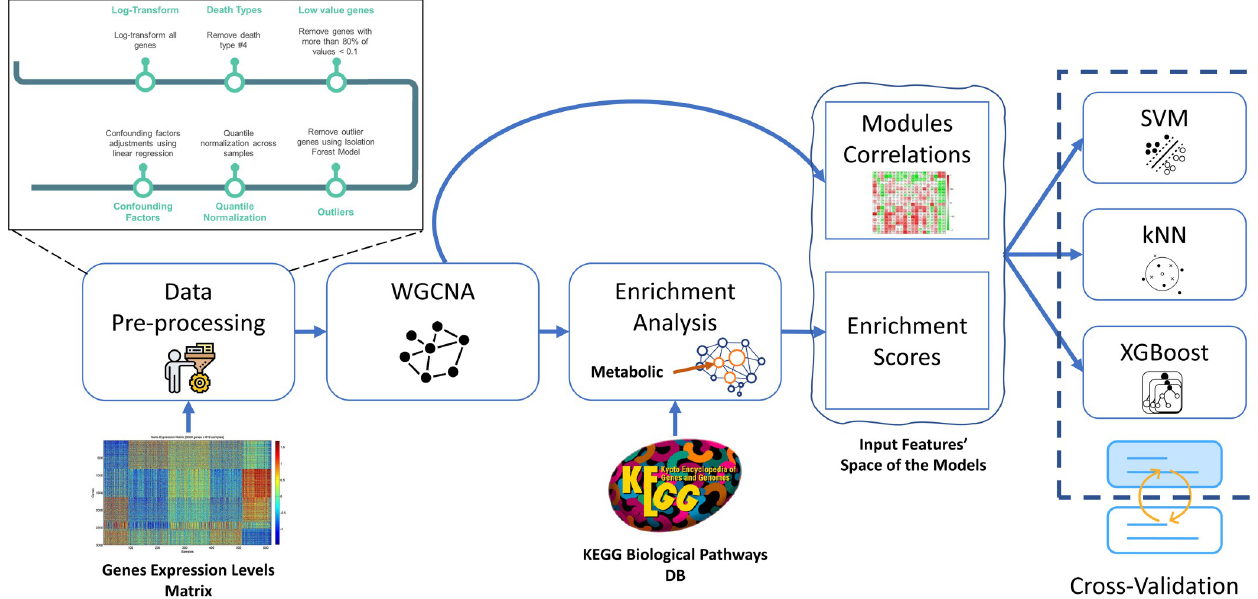
Fig 1. Schematic workflow of data preprocessing and the proposed methodology.